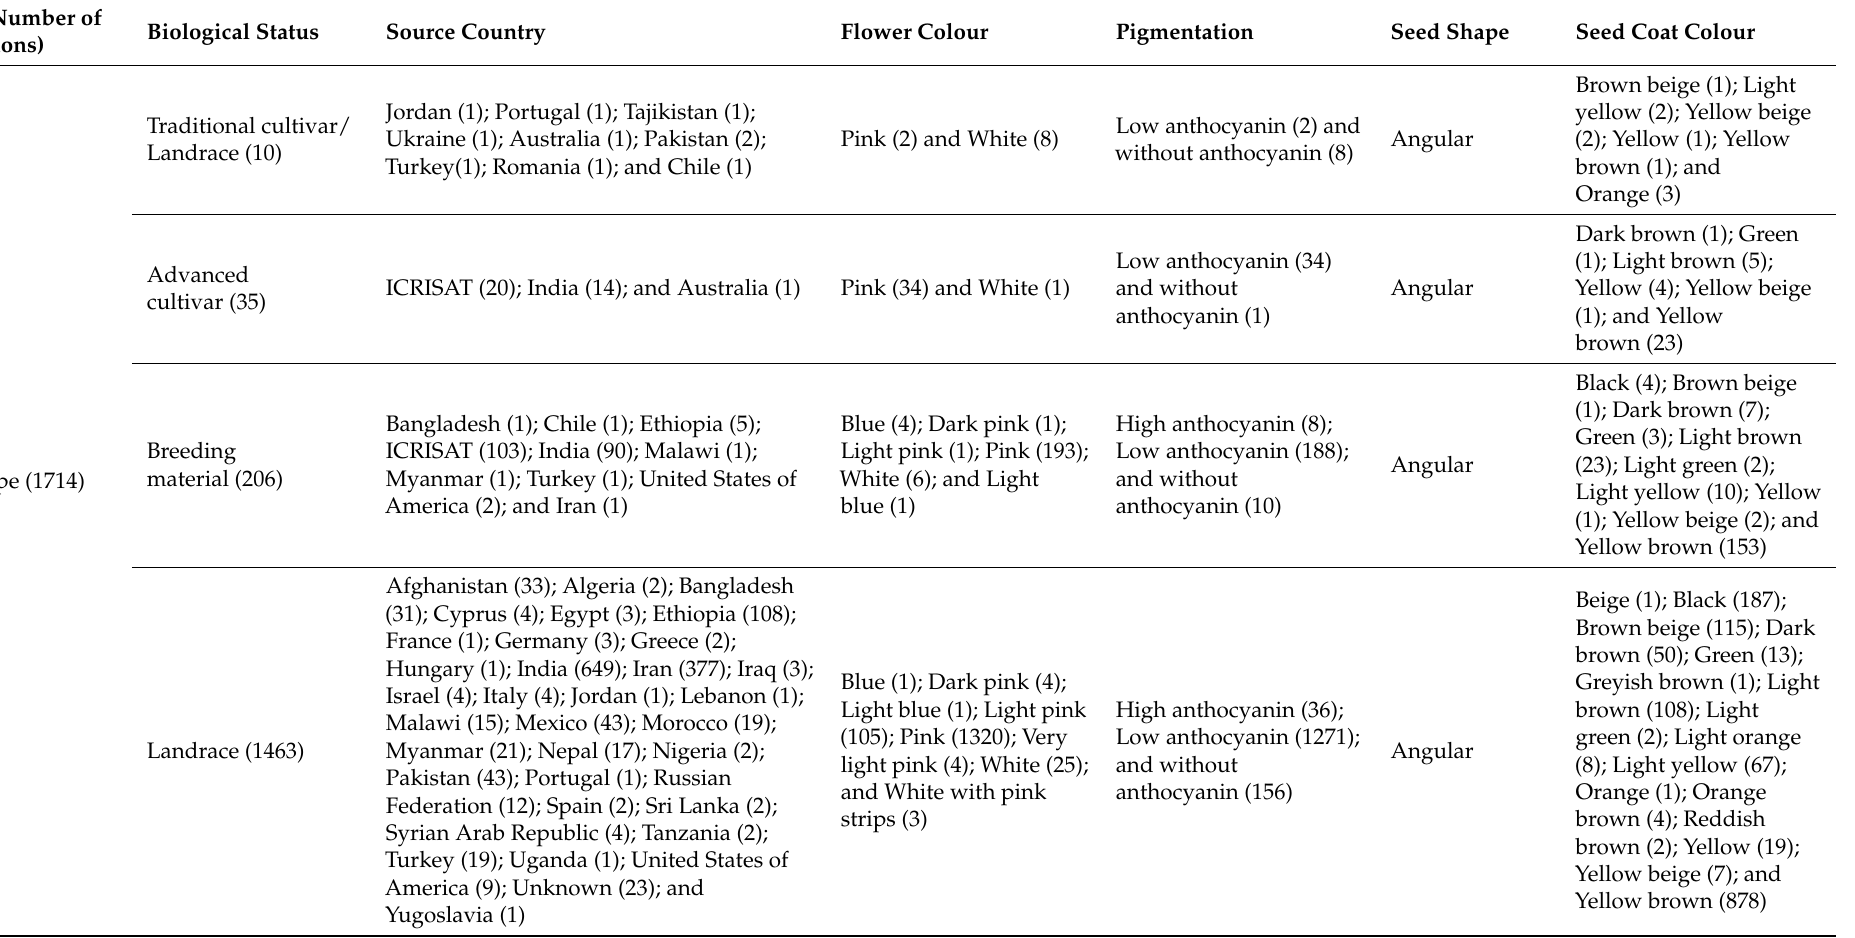
Table 1. Classification of a chickpea composite collection based on biological status, source country, flower colour, pigmentation, seed shape, and seed coat